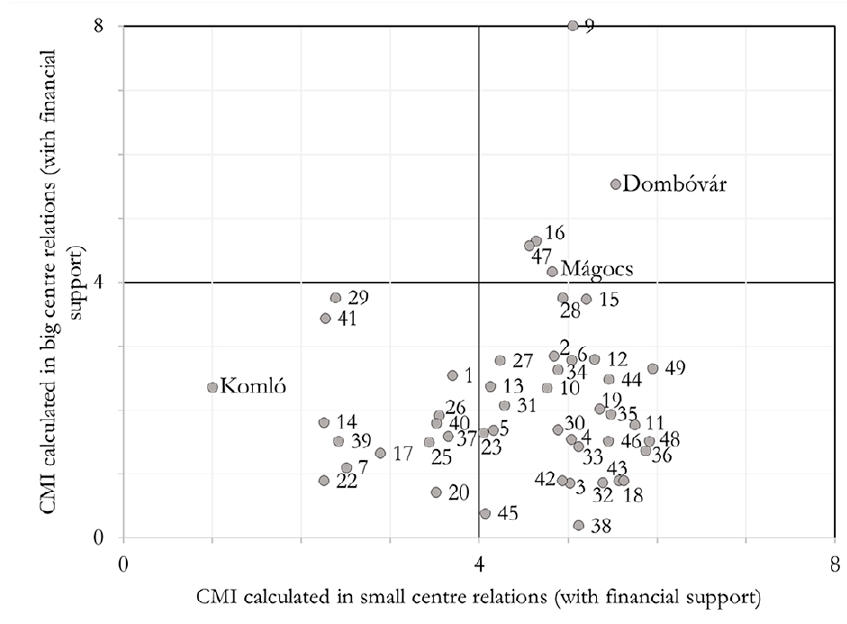
Figure 6. Comparing the CMI-values of settlements including subsidies according to the internal and external model Source: based on the authors’ own